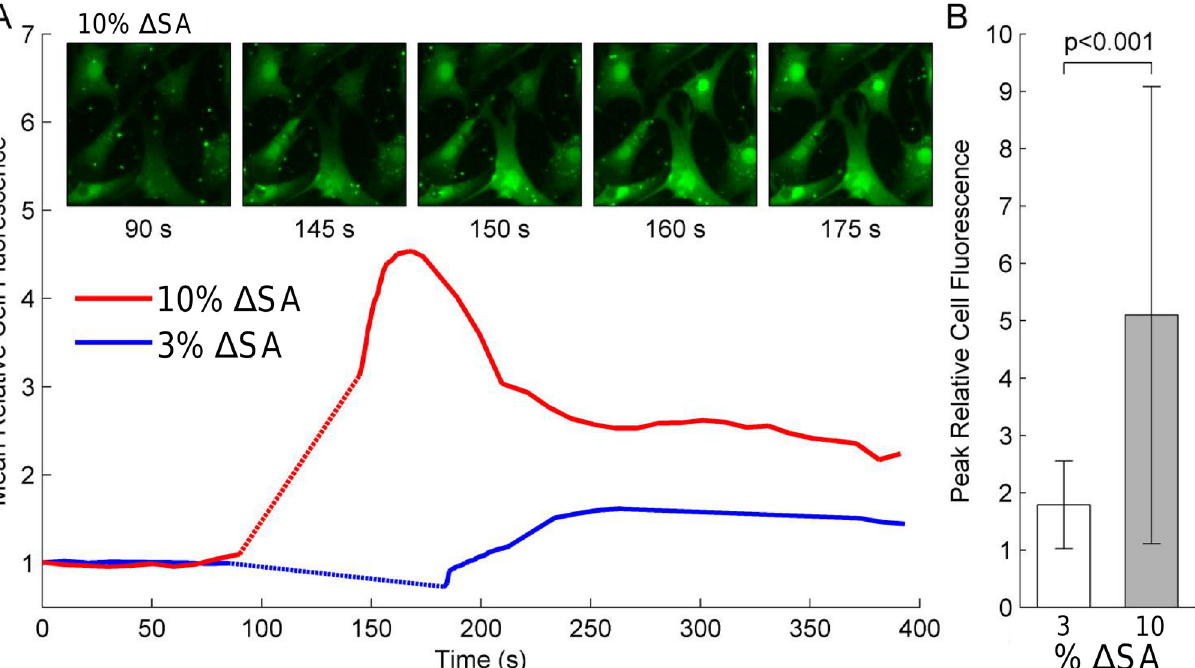
Fig 6. Intracellular calcium level responses of primary bovine fibroblasts to single sinusoidal equi-biaxial strains. Cells were loaded with Fluo4 calcium indicator dye and subjected to strains of 3 or 10% change in membrane surface area ( Δ SA). (A) Following single 6 s long stretch (dotted line), cells stretched to 10% Δ SA showed large transient increases in fluorescence relative to baseline (mean of 77 cells), while cells stretched to 3% Δ SA showed little response (mean of 44 cells). Images of cells stretched to 10% Δ SA revealed differences between neighboring cells in the timing of their response to stretch, with some cells responding immediately and other requiring up to 10 s to respond. (B) The changes in fluorescence were significantly greater with 10% Δ SA than with 3% Δ SA (p <